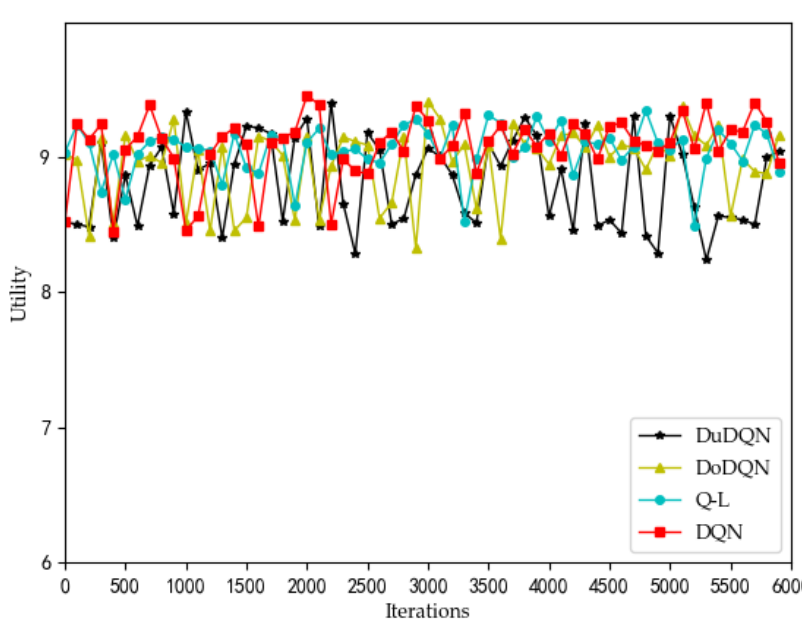
Figure 13. Comparison of utility using different methods.